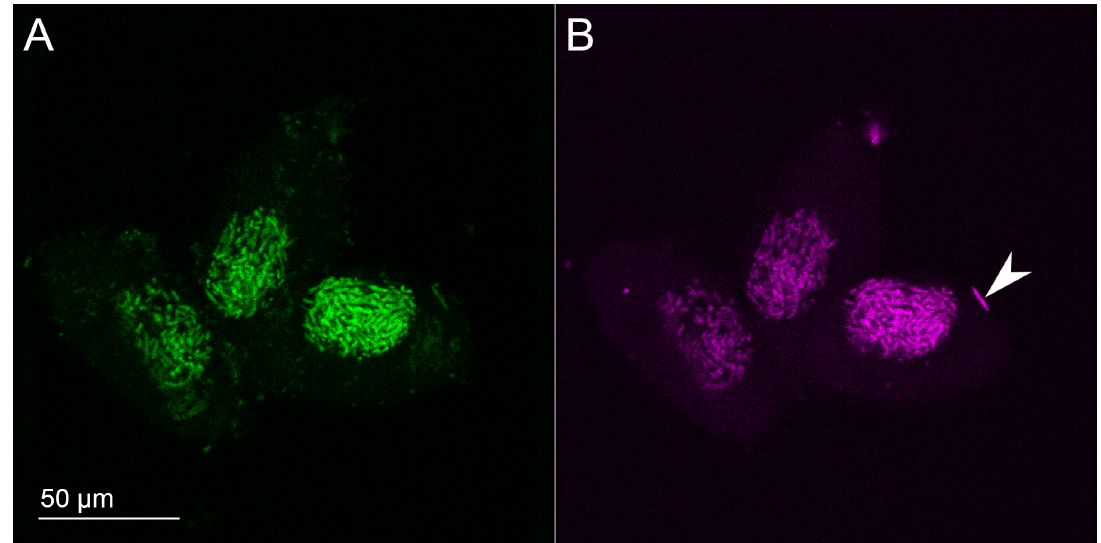
Figure 4. Cells of P. putrinum with symbionts in macronuclei labeled with the probes Eub338 ( A ) and Gyak567 ( B ). Single IF lying outside the macronucleus is shown with the white